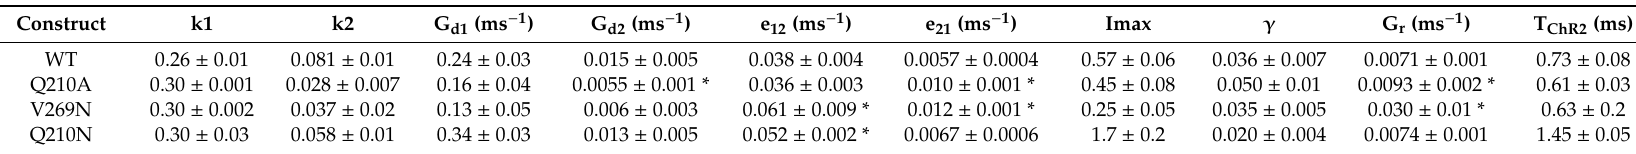
Table 3. Summary of parameter optimization for the four-state photocycle model. Values are the average of parameters obtained from each cell ± SEM (n = 3–7). Statistically significant values are denoted with * ( p <